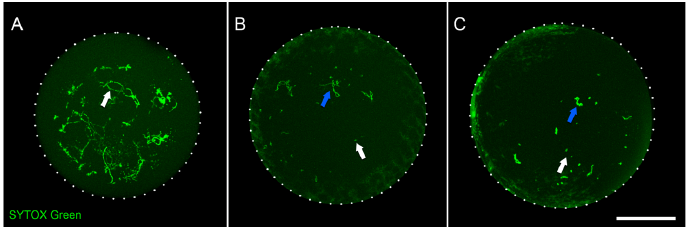
Figure 1. Follicle size allows discrimination of developmental stages of chicken oocytes. ( A )—nucleus from 2 mm stage follicle (SWF). White arrow indicates lampbrush chromosomes. ( B )—nucleus from 3 mm stage follicle. White arrow indicates microchromosome, blue arrow indicates macrochromosome. ( C )—nucleus from 4 mm stage follicle (LWF). White arrow indicates condensed microchromosome, blue arrow indicates condensed macrochromosome. Staining with Sytox Green followed by confocal laser scanning microscopy; maximum intensity projection images are shown. Scale bar—100 µ m.